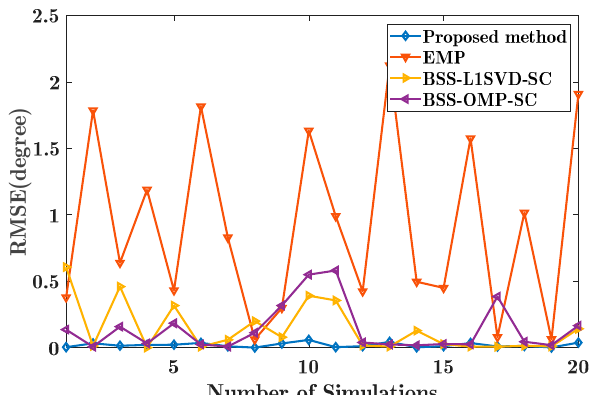
Electronics 2020 , 9 , x FOR PEER REVIEW Figure 13. The DOA estimation of the target. Figure 13. The DOA estimation of the target.